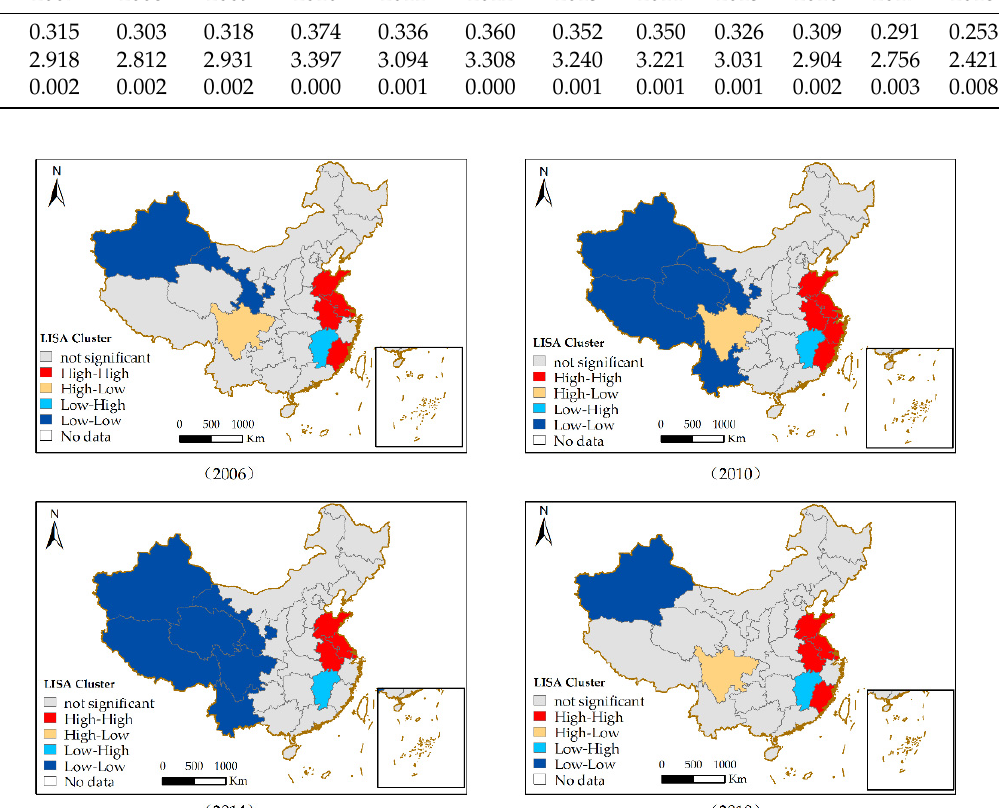
Figure 6. Lisa cluster map of DVI in China.